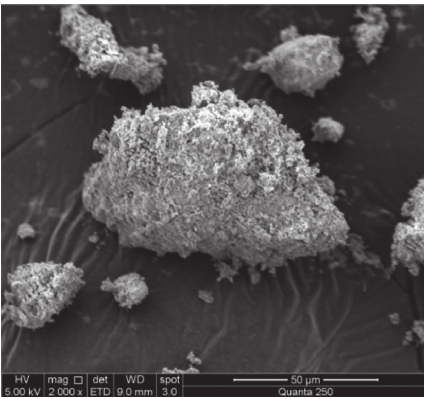
Figure 6: SEM image of the ZnO/sepiolite composite prepared by the powder sintering method.